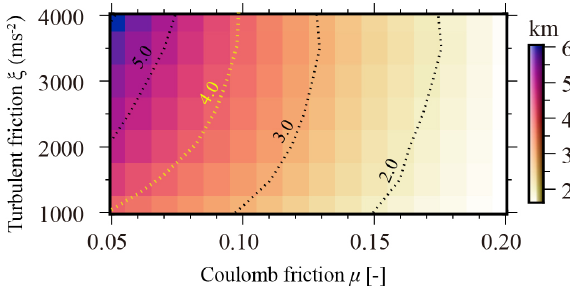
Figure 12. Variations in runout distance for varying friction param- eters ( µ and ξ ) of the Voellmy–Salm model. The dotted lines rep- resent the contour lines with the yellow one representing the runout distance (4km) that will threaten the Qinghai–Tibet